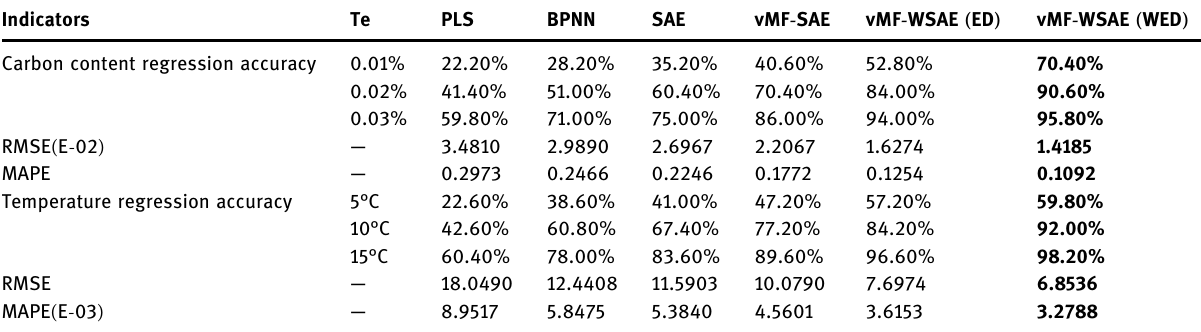
Table 6: Prediction performance comparison of the proposed method with other ablation experiments Indicators Carbon content regression accuracy